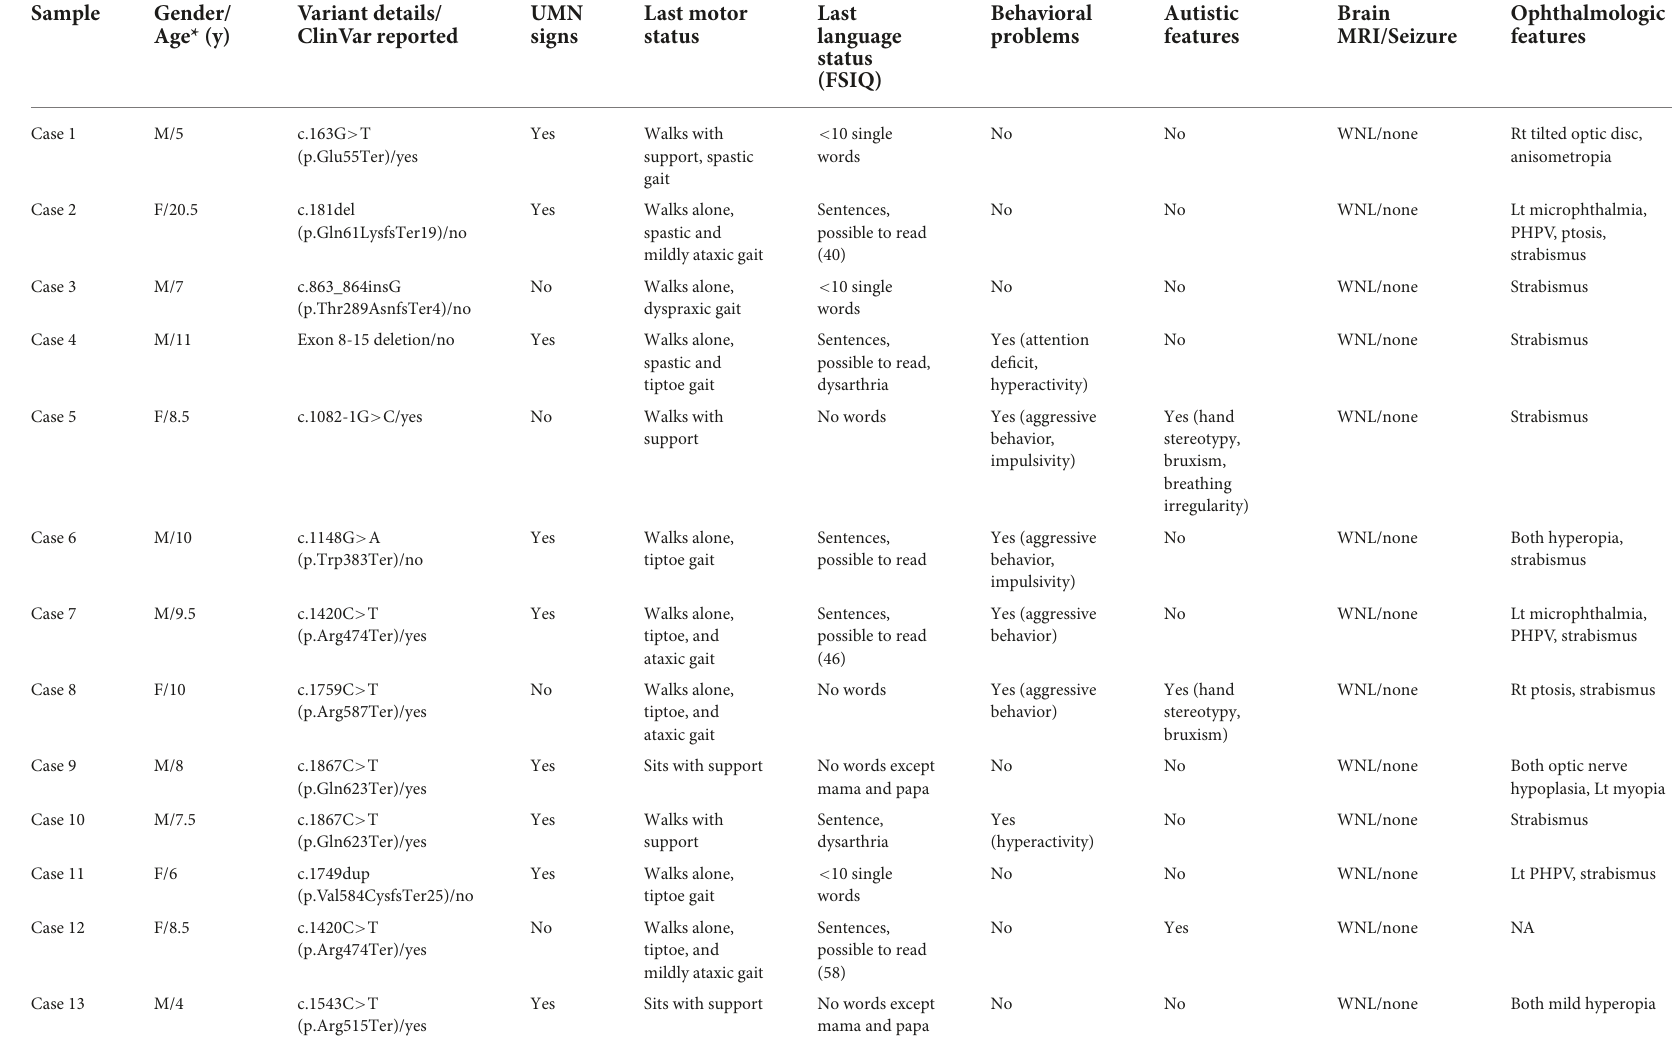
TABLE 1 Neurodevelopmental disorder patients with de novo loss-of-function mutations in CTNNB1 (NM_001904.4).